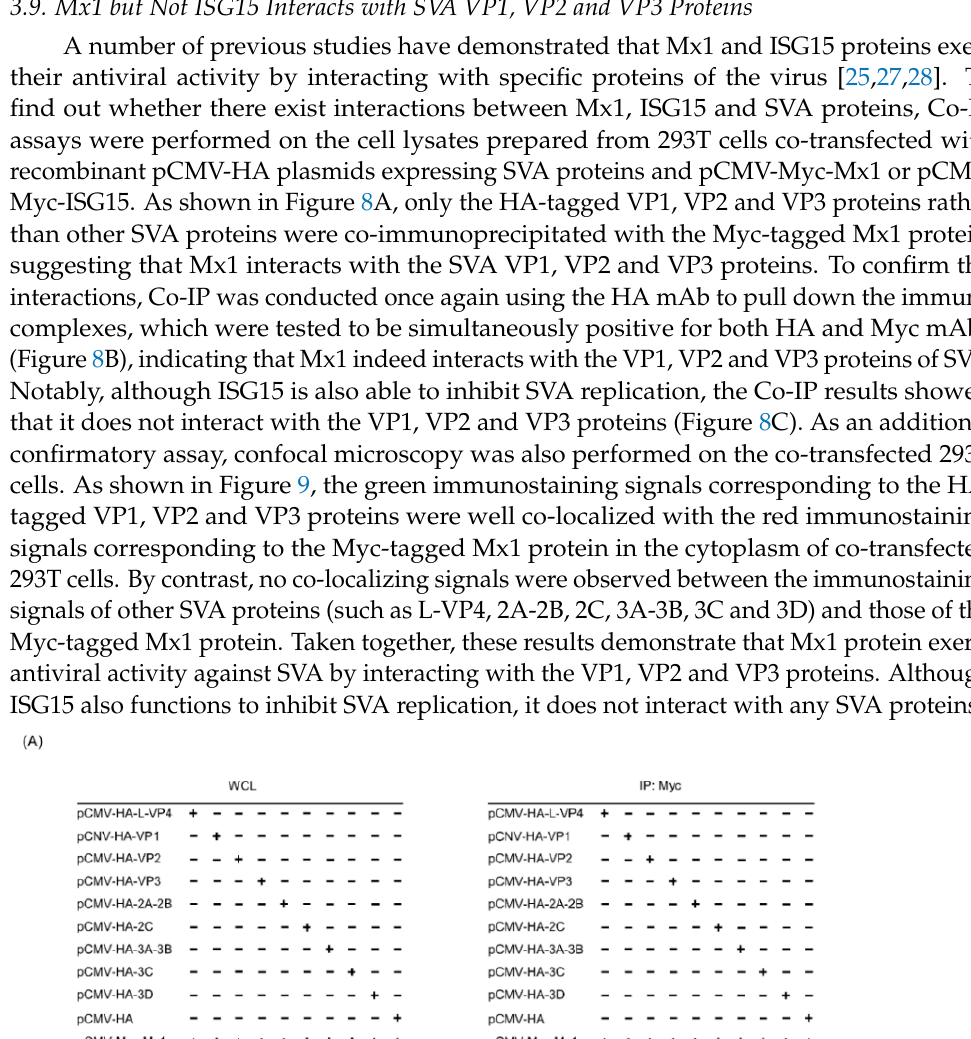
Figure 8. Mx1 but not ISG15 interacts with the VP1, VP2 and VP3 proteins of SVA. ( A , B ) WB and co-immunoprecipitation (Co-IP) analyses of HA-tagged SVA proteins and Myc-tagged Mx1 protein in co-transfected HEK293T cells. HEK293T cells were co-transfected with 1.25 μ g of pCMV-HA-L- VP4, pCMV-HA-VP1, pCMV-HA-VP2, pCMV-HA-VP3, pCMV-HA-2A-2B, pCMV-HA-2C, pCMV- HA-3A-3B, pCMV-HA-3C, pCMV-HA-3D or pCMV-HA, and 1.25 μ g of pCMV-Myc-Mx1. At 36 hpt, the cells were harvested to prepare whole cell lysates (WCL) for WB and Co-IP analyses using mouse anti-Myc and -HA mAbs. ( C ) WB and Co-IP analyses of HA-tagged SVA proteins and Myc-